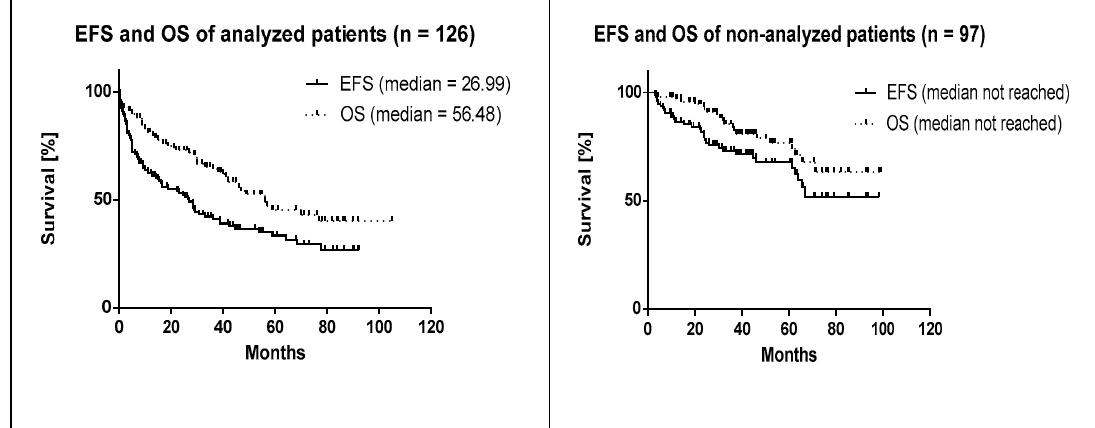
Figure 2. Survival in patients with bone marrow involvement ≥ 5% compared to patients without available diagnostic samples. EFS = event-free survival, OS = overall survival.